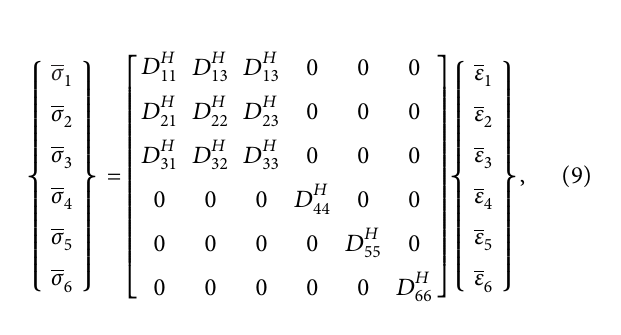
Figure 1: A 3D unit